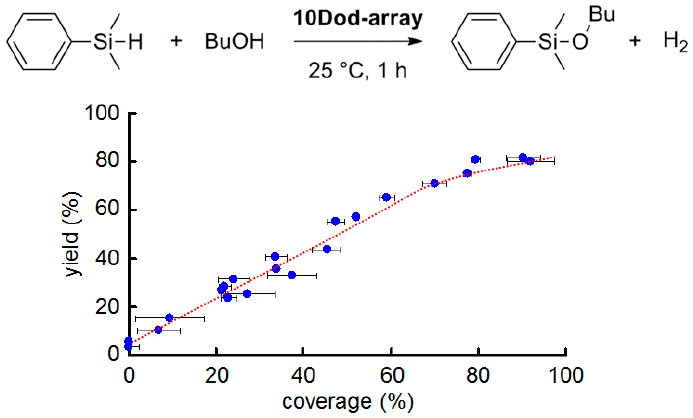
Figure 3. AuNP coverage dependent catalytic activity of the 10Dod-array . Reaction condition: dimethylphenylsilane (DMPS) (150 μ mol) in BuOH (3.0 mL) at 25 °C for 1 h.